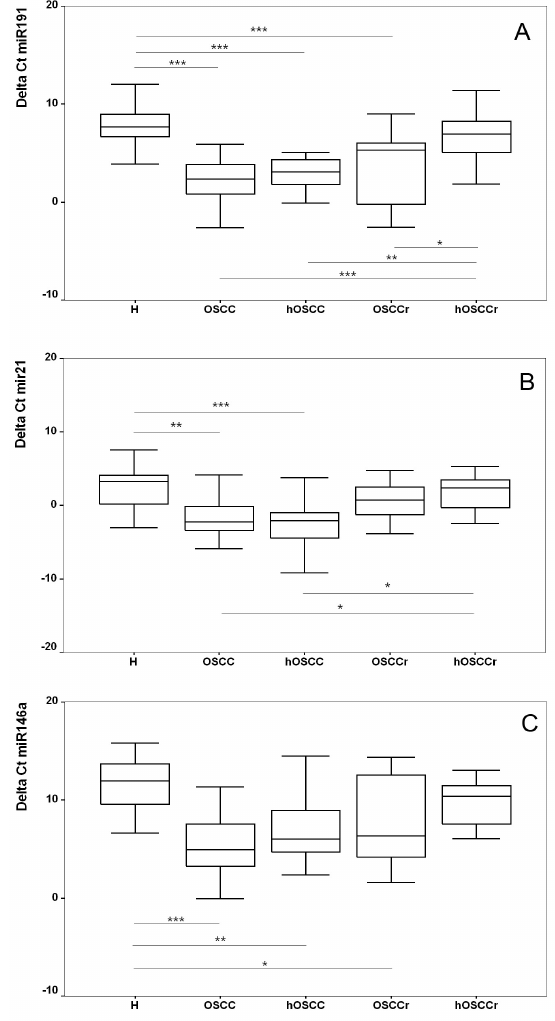
Figure 2. Expression levels of miRNAs. The box plots report the normalized expression levels of miR-191 ( A ), miR-21 ( B ), and miR-146a ( C ). Only miRNAs showing different expression among patient groups are included. Normalized expression levels are expressed as ∆⁻ C t ; lower ∆⁻ C t values signify higher expression levels. The box represents the interquartile range of the ∆⁻ C t . The line across the box indicates the median, while the whiskers extend to the highest and lowest values. Level of significance in post hoc analysis for differences between groups were reported (* if p value < 0.05; ** if p value < 0.01; *** if p value < 0.001). H, healthy donor; OSCC, Oral Squamous Cell Carcinoma; hOSCC, distant healthy mucosa of OSCC patients; OSCCr, OSCC in remission; hOSCCr, distant healthy mucosa of OSCC patients in remission.